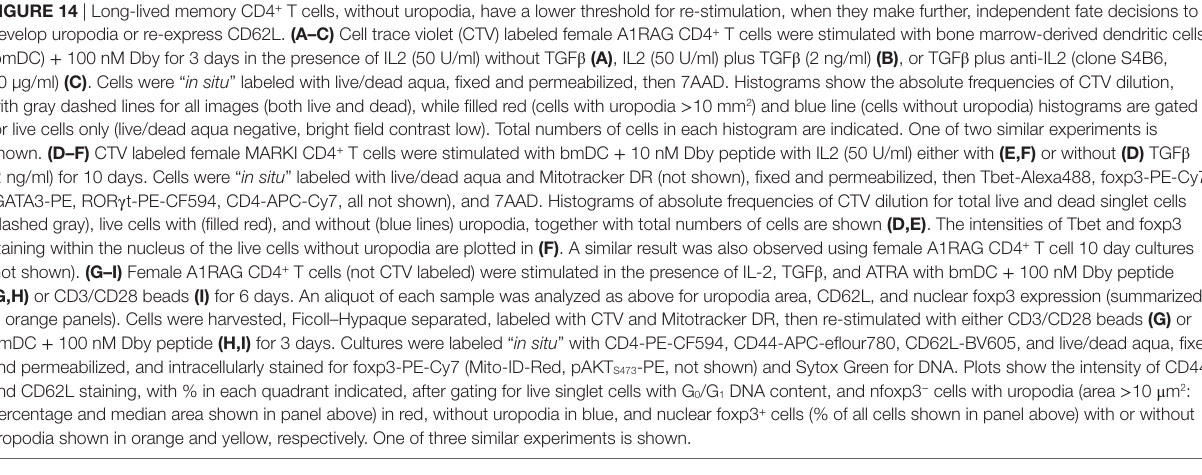
FigUre 14 | Long-lived memory CD4 + T cells, without uropodia, have a lower threshold for re-stimulation, when they make further, independent fate decisions to develop uropodia or re-express CD62L. (a–c) Cell trace violet (CTV) labeled female A1RAG CD4 + T cells were stimulated with bone marrow-derived dendritic cells (bmDC) + 100 nM Dby for 3 days in the presence of IL2 (50 U/ml) without TGF β (a) , IL2 (50 U/ml) plus TGF β (2 ng/ml) (b) , or TGF β plus anti-IL2 (clone S4B6, 50 µg/ml) (c) . Cells were “ in situ ” labeled with live/dead aqua, fixed and permeabilized, then 7AAD. Histograms show the absolute frequencies of CTV dilution, with gray dashed lines for all images (both live and dead), while filled red (cells with uropodia > 10 mm 2 ) and blue line (cells without uropodia) histograms are gated for live cells only (live/dead aqua negative, bright field contrast low). Total numbers of cells in each histogram are indicated. One of two similar experiments is shown. (D–F) CTV labeled female MARKI CD4 + T cells were stimulated with bmDC + 10 nM Dby peptide with IL2 (50 U/ml) either with (e,F) or without (D) TGF β (2 ng/ml) for 10 days. Cells were “ in situ ” labeled with live/dead aqua and Mitotracker DR (not shown), fixed and permeabilized, then Tbet-Alexa488, foxp3-PE-Cy7, (GATA3-PE, ROR γ t-PE-CF594, CD4-APC-Cy7, all not shown), and 7AAD. Histograms of absolute frequencies of CTV dilution for total live and dead singlet cells (dashed gray), live cells with (filled red), and without (blue lines) uropodia, together with total numbers of cells are shown (D,e) . The intensities of Tbet and foxp3 staining within the nucleus of the live cells without uropodia are plotted in (F) . A similar result was also observed using female A1RAG CD4 + T cell 10 day cultures (not shown). (g–i) Female A1RAG CD4 + T cells (not CTV labeled) were stimulated in the presence of IL-2, TGF β , and ATRA with bmDC + 100 nM Dby peptide (g,h) or CD3/CD28 beads (i) for 6 days. An aliquot of each sample was analyzed as above for uropodia area, CD62L, and nuclear foxp3 expression (summarized in orange panels). Cells were harvested, Ficoll–Hypaque separated, labeled with CTV and Mitotracker DR, then re-stimulated with either CD3/CD28 beads (g) or bmDC + 100 nM Dby peptide (h,i) for 3 days. Cultures were labeled “ in situ ” with CD4-PE-CF594, CD44-APC-eflour780, CD62L-BV605, and live/dead aqua, fixed and permeabilized, and intracellularly stained for foxp3-PE-Cy7 (Mito-ID-Red, pAKT S473 -PE, not shown) and Sytox Green for DNA. Plots show the intensity of CD44 and CD62L staining, with % in each quadrant indicated, after gating for live singlet cells with G 0 /G 1 DNA content, and nfoxp3 − cells with uropodia (area > 10 μ m 2 : percentage and median area shown in panel above) in red, without uropodia in blue, and nuclear foxp3 + cells (% of all cells shown in panel above) with or without uropodia shown in orange and yellow, respectively. One of three similar experiments is